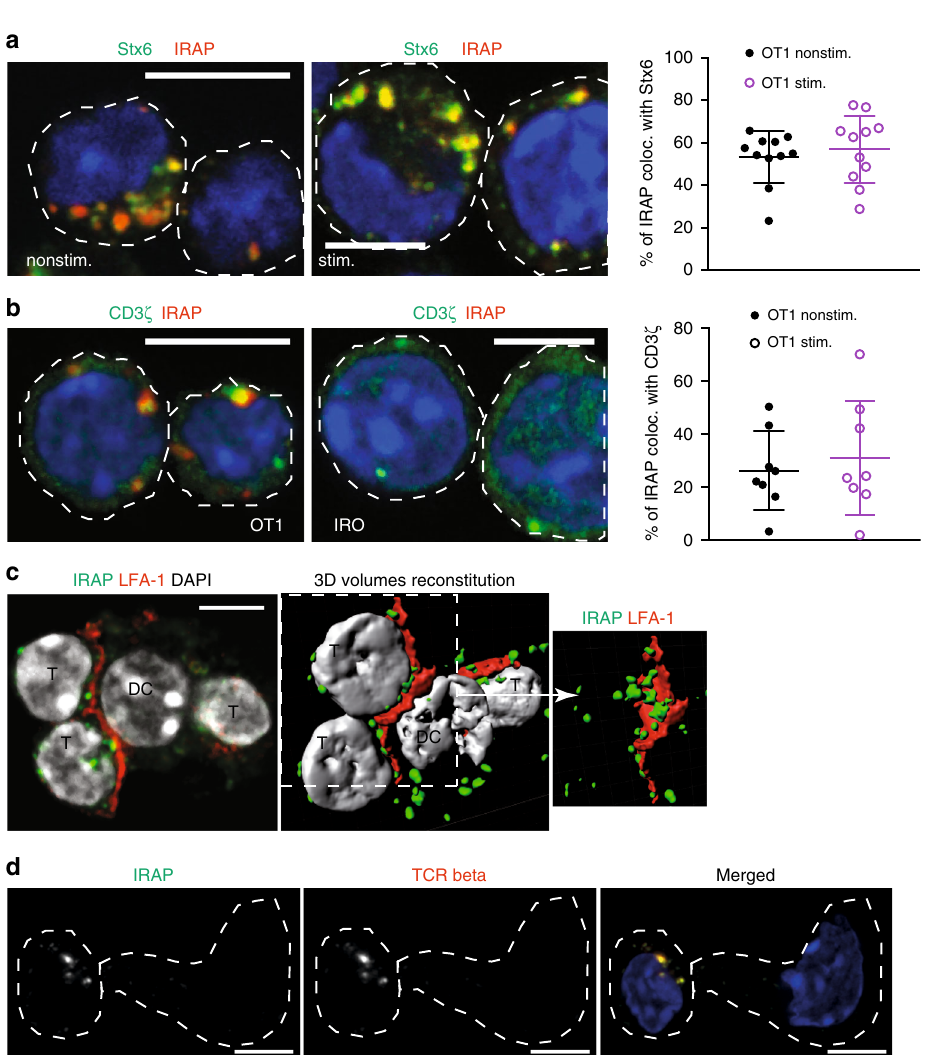
Fig. 5 IRAP colocalizes with the TCR in primary murine T cells. a OT1 effector T cells were spread on poly-lysine (nonstim.) or CD3 ε -coated (stim.) slides for 10 min, fi xed and stained with antibodies speci fi c for IRAP and Stx6. Each dot represents a cell ( n = 11 cells per condition). Bars represent 5- μ m scale. b OT1 T cells were spread on CD3 ε -coated slides for 10 min, fi xed and stained with antibodies speci fi c for IRAP and the ζ chain ( n = 8 cells per condition). Bars represent 5- μ m scale. Images are representative of two independent experiments. c Confocal microscopy and tri-dimensional reconstitution of conjugates formed by SIINFEKL-pulsed dendritic cells and OT1 naive T cells. After fi xation, the cells were stained with speci fi c antibodies for LFA-1 (red), IRAP (green) and DAPI (grey). Images are representatives for two independent experiments. Bars represent 5- μ m scale. d Confocal microscopy of conjugates formed by SIINFEKL-pulsed dendritic cells and OT1 naive T cells. After fi xation, the cells were stained with speci fi c antibodies for IRAP (green) and TCRb (red). Bars represent 5- μ m scale. Images are representatives for two independent